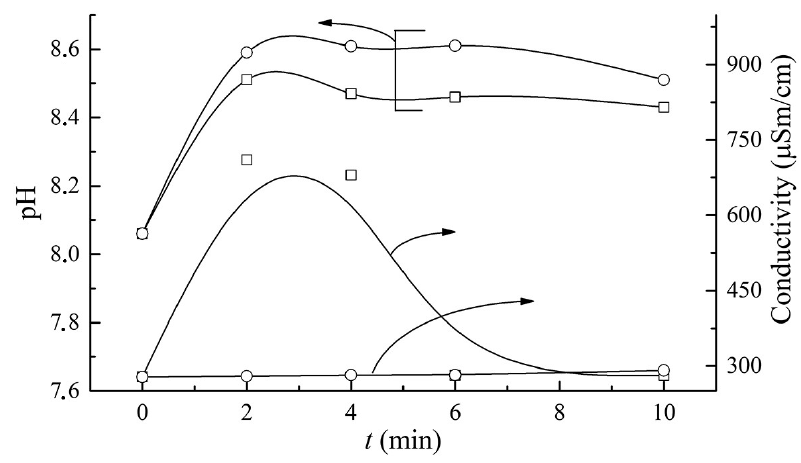
Figure 4. Time behavior of the pH-index and conductivity in ground water: barrier discharge ( (cid:3) ); bubble discharge ( ). (cid:35)